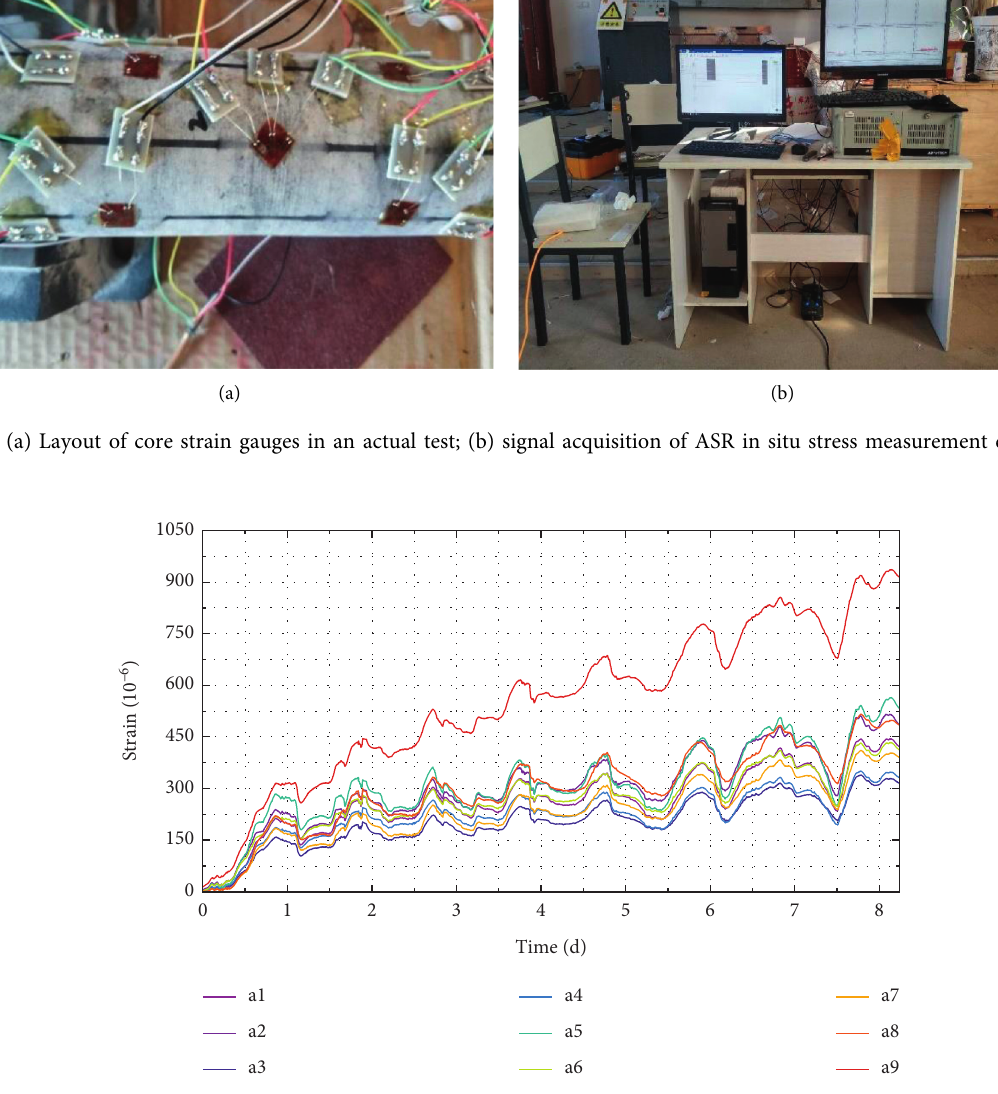
Figure 6: − 1180m core sample anelastic recovery strain